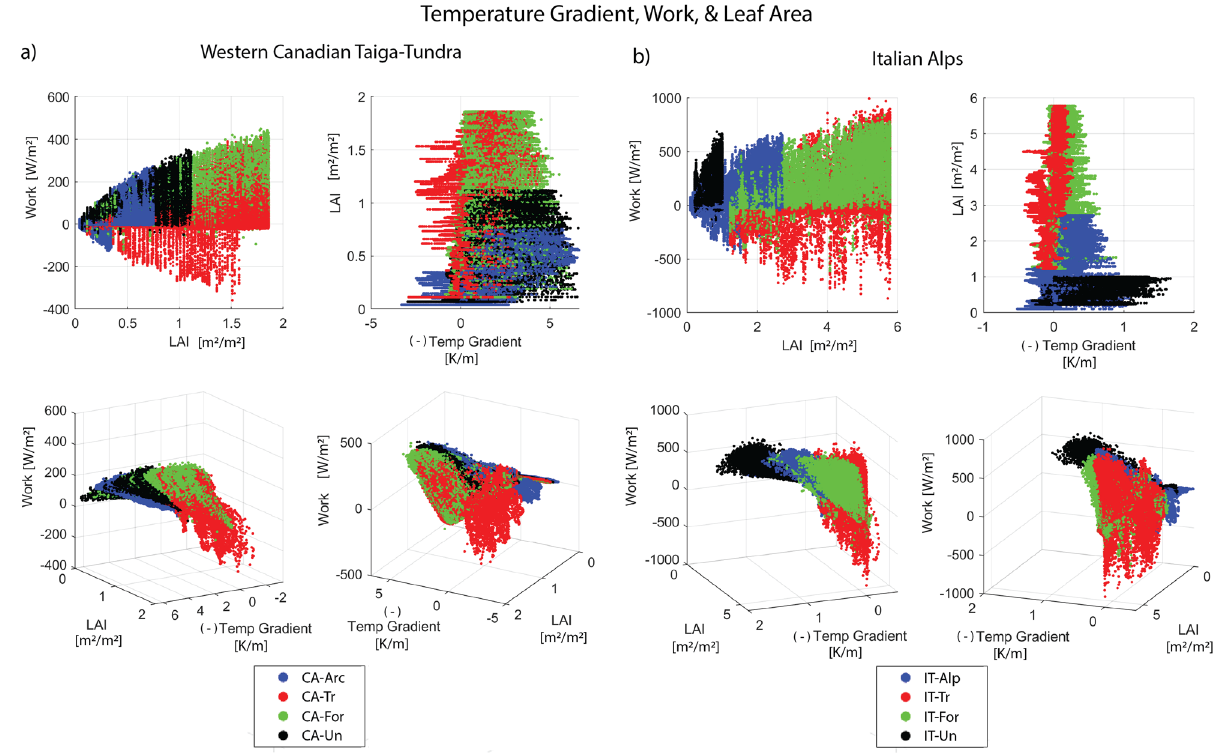
Figure 6. Four projected views from the 3-D plot of work, temperature gradient, and total leaf area index (LAI) for the ( a ) Western Canadian Taiga-Tundra and ( b ) Italian Alps scenarios. The top panels display that increases in LAI lead to increases in the magnitude of work and smaller resultant temperature gradients. The negative of the resultant temperature gradient is plotted. Thus, positive values refer to negative temperature gradients such that larger values indicate stronger declines in temperature from the earth surface to the atmosphere. Negative values indicate positive temperature gradients, or temperature inversions. The 3-D views in the bottom panels show the transition from flatter curves to greater magnitudes of work with increases in resultant temperature gradient as more LAI is incorporated for each set of environmental conditions (i.e., alpine, subalpine). The simulated alpine/Arctic forest scenarios ( red ; X-Tr ) exhibit considerable negative work performed since the LAI is beyond the supported limit of the local environmental